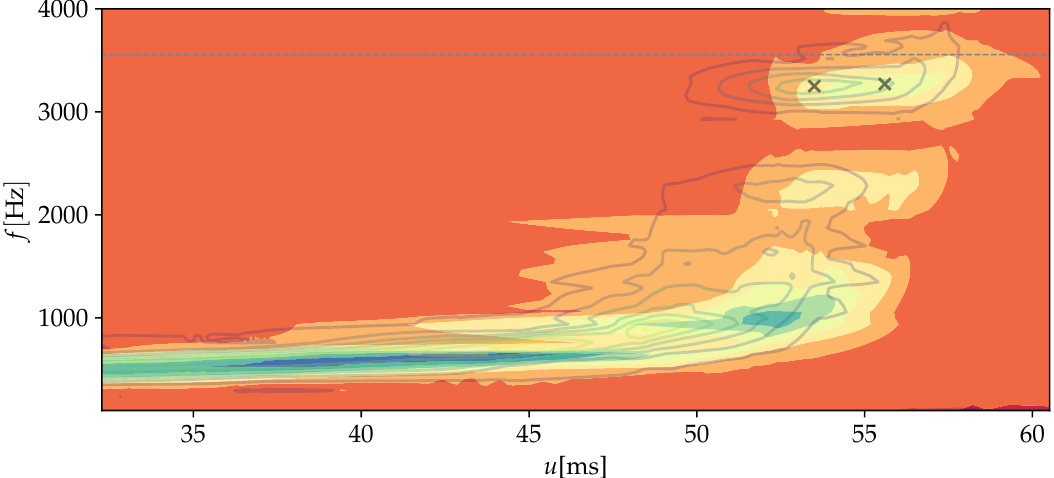
Figure 6. Spectrogram for resolution R4 (filled contours) and resolution R3 (solid lines). We mark the dominant postmerger frequency for the two resolutions as black crosses. In addition we include as a horizontal dashed line the postmerger frequency estimate derived from Reference